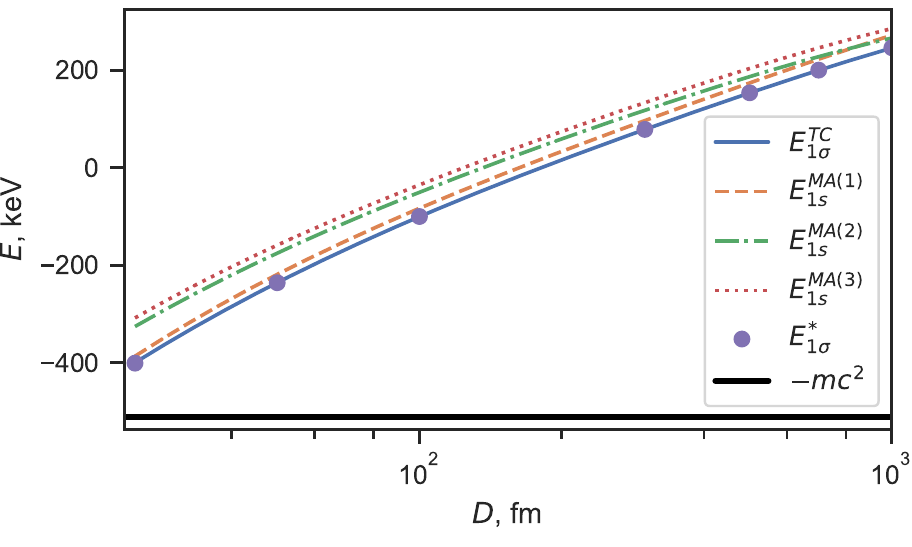
Figure 1. The ground-state Dirac energy of the U–Pb quasimolecule evaluated with the TC, MA(1), MA(2), and MA(3) potentials. E ∗ corresponds to the data from Ref. 1 σ